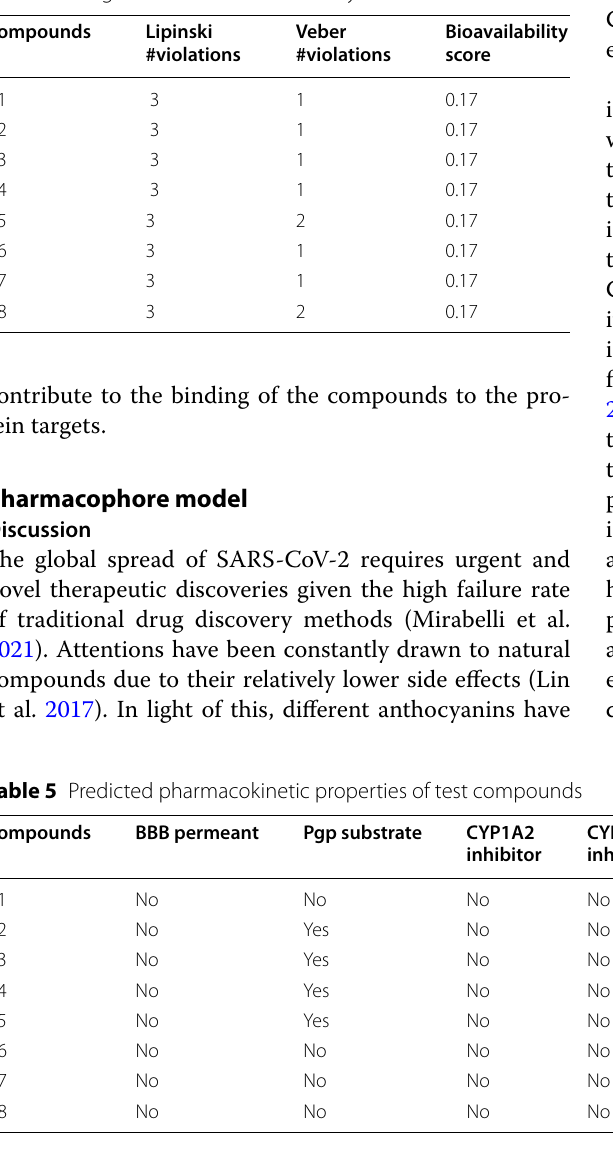
Table 4 Drug-likeness and bioavailability